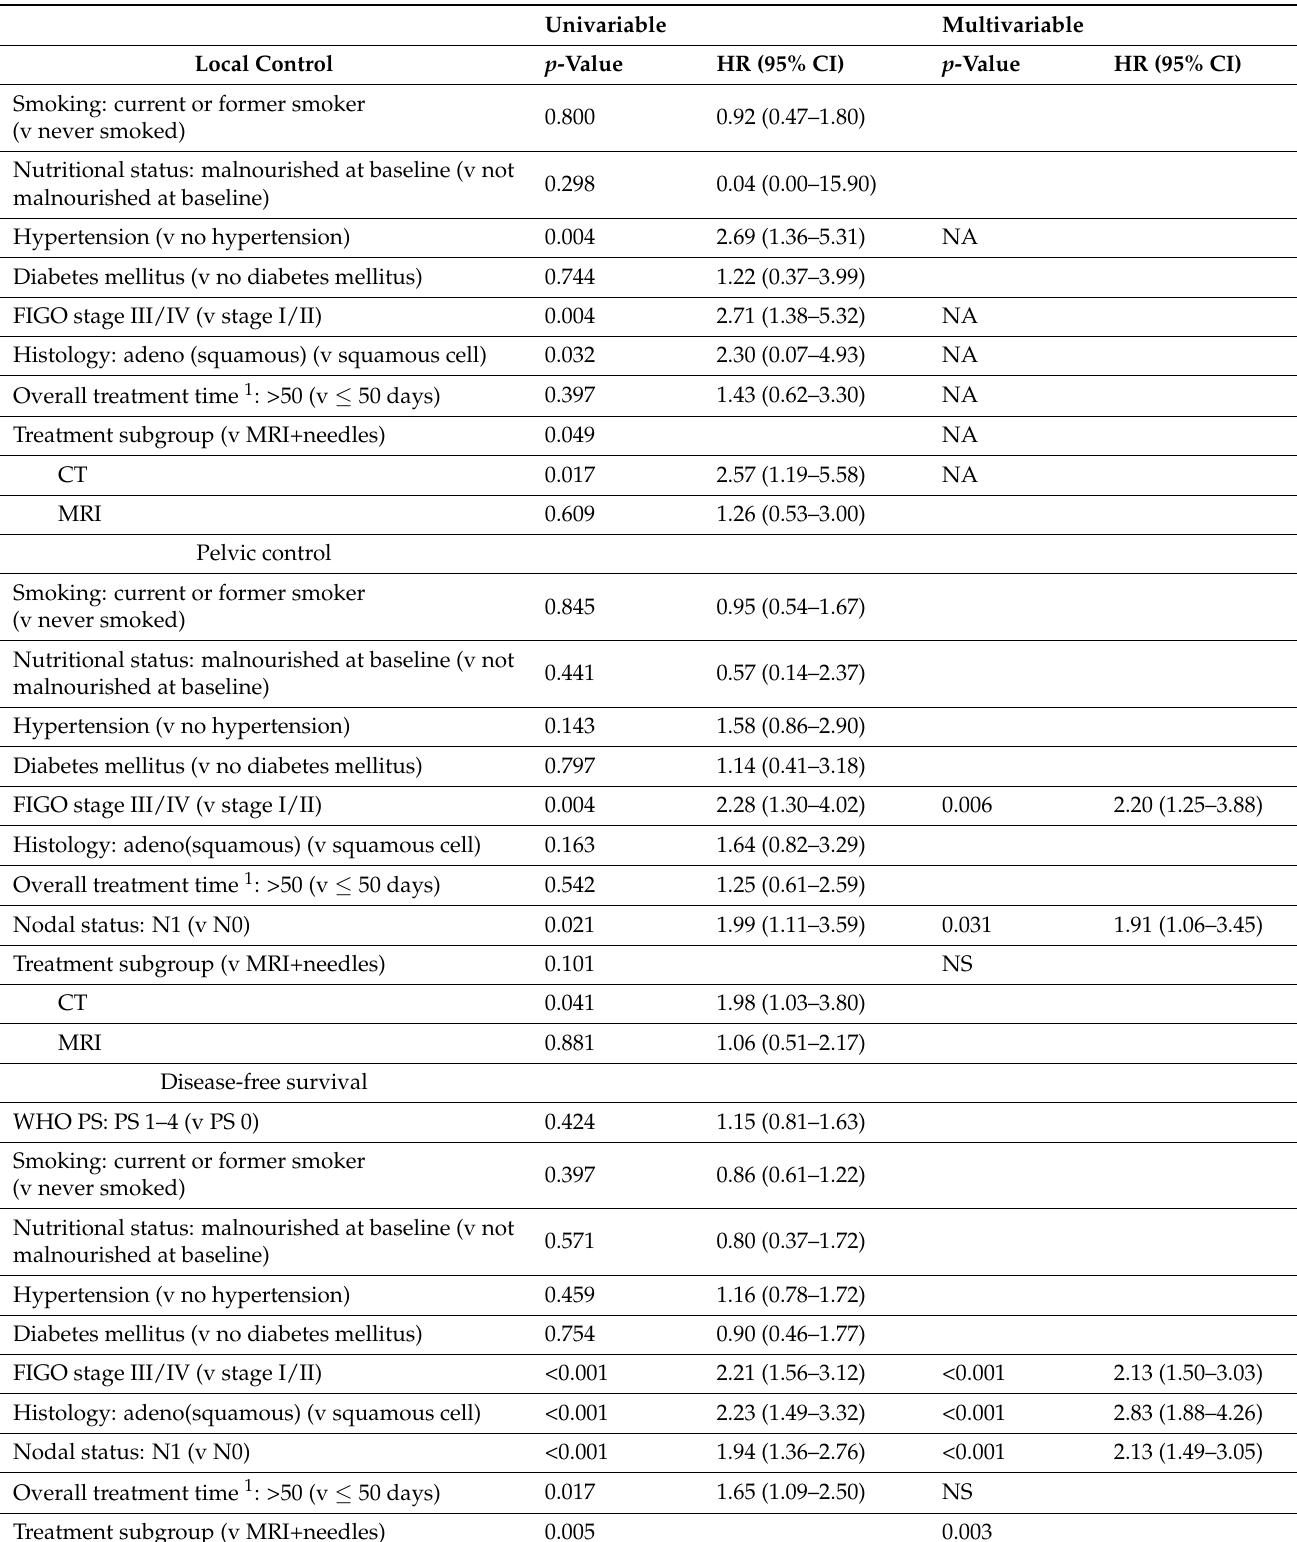
Table 2. Univariable and multivariable Cox regression analysis for local control, pelvic control, disease-free survival, and overall survival. Univariable